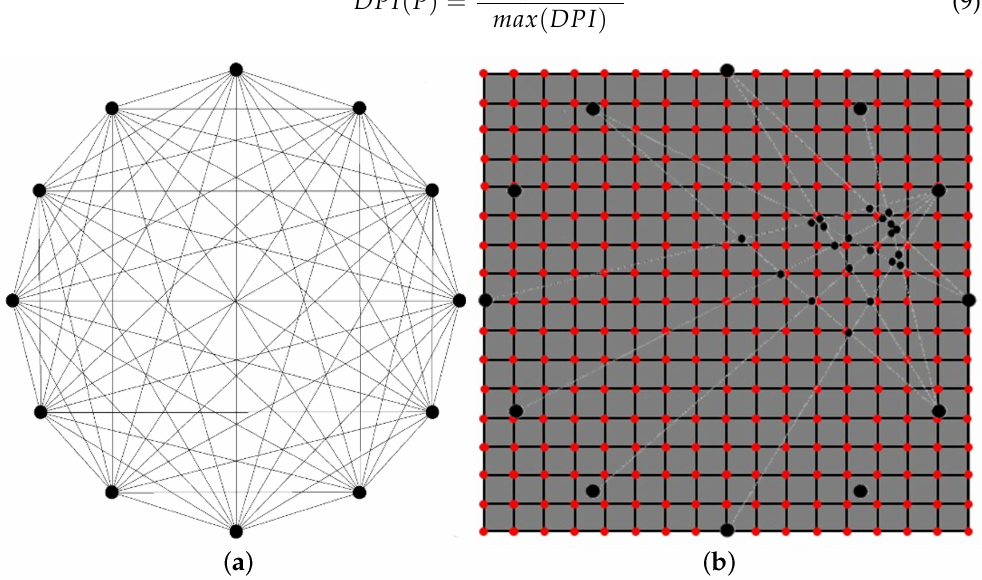
Figure 3. Piezoelectric transducer array and resulting propagation paths where damage indices are calculated ( a ). Structural mesh where damage probability index is derived using probability distribution function ( b